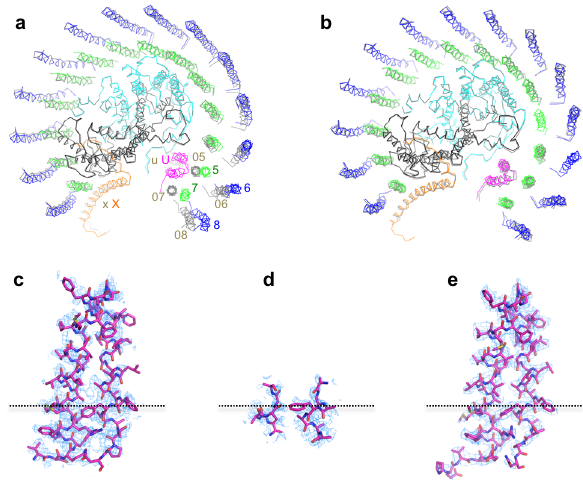
Fig. 5 Structural comparison of the monomers in the dimer. a Top view of superposition of the C α carbons of the RC M-subunits between monomer A (colored) and monomer B (gray) shown by ribbon representations and viewed from the periplasmic side. Color scheme for the proteins in monomer A is the same as in Fig. 1. PufX (X, x) and protein-U (U, u) are indicated by their chain ID (X and U in monomer A, x and u in monomer B). The RC H-subunits are omitted for clarity. Two αβ -subunits in monomer B indicated by their chain ID 05, 06, 07, and 08 are largely deviated from the corresponding polypeptides in monomer A (chain ID 5, 6, 7 and 8). b Similar superposition between monomer A (colored) and a monomeric Rba. sphaeroides LH1 – RC (gray, PDB: 7F0L) reported previously. c – e Structures of protein-U with their density maps at a contour level of 4 σ in monomer A ( c ), monomer B ( d ), and the monomeric core complex ( e ). Dotted lines indicate the position of Phe46 of protein-U. Most parts of protein-U in monomer B are